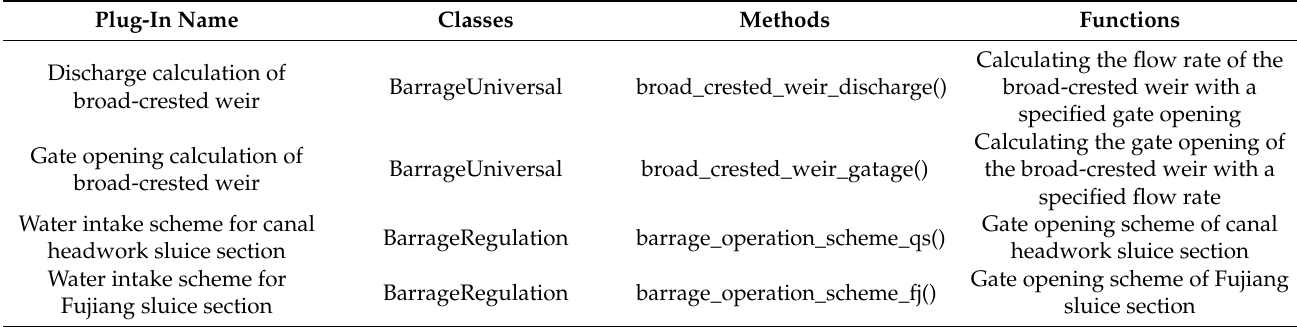
Table 5. Water intake complex plug-in